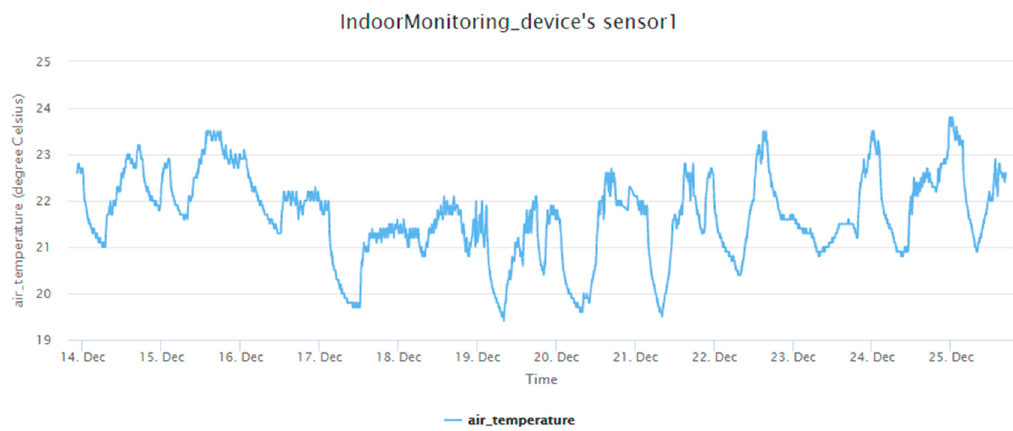
Figure 11. The indoor monitoring device.